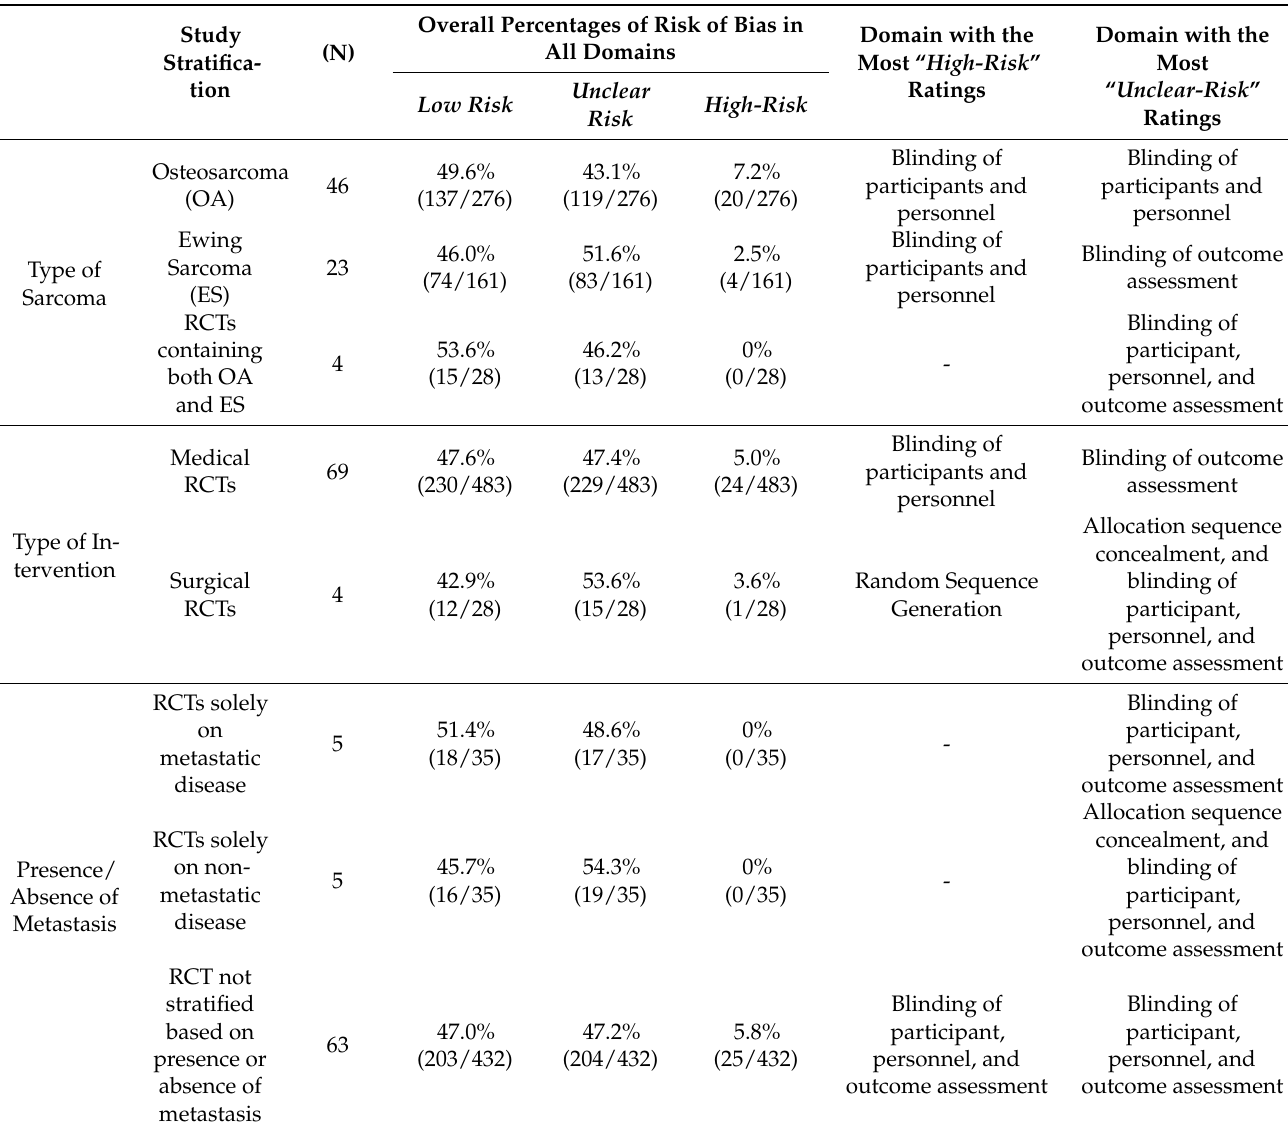
Table A2. Overall risk of bias stratified by type of sarcoma (osteosarcoma vs. Ewing sarcoma), type of intervention (medical vs. surgical), and presence or absence of